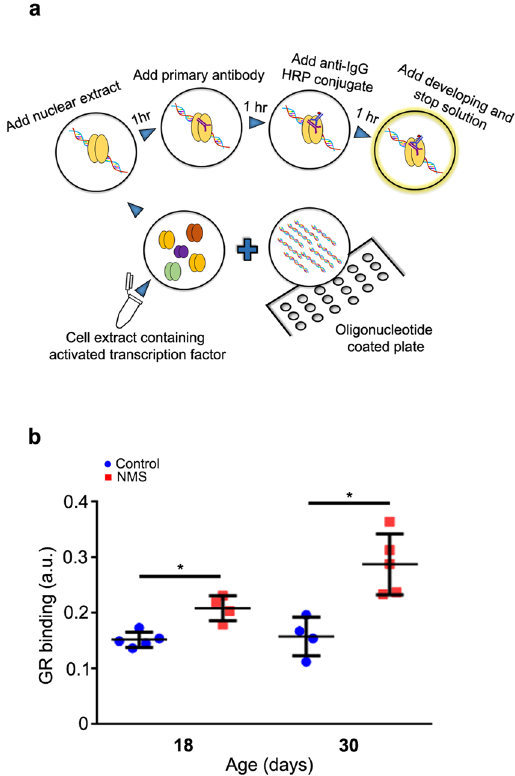
Figure 3. NMS effects on nuclear GR binding in the gastric mucosa at 18 and 30 days. ( a ) Flow chart of the TransAM TM GR binding assay. Activated transcription factor in nuclear extract binds to the consensus- binding site on the oligonucleotides immobilized in the well, and it is detected after incubation with anti- GR, followed by secondary HRP – conjugated antibody and reaction development. ( b ) GR nuclear binding (a.u.) for control (blue) and NMS (red) groups. Values are individually represented as well as means ± SD. * P < 0.05 when compared to control group by Student t